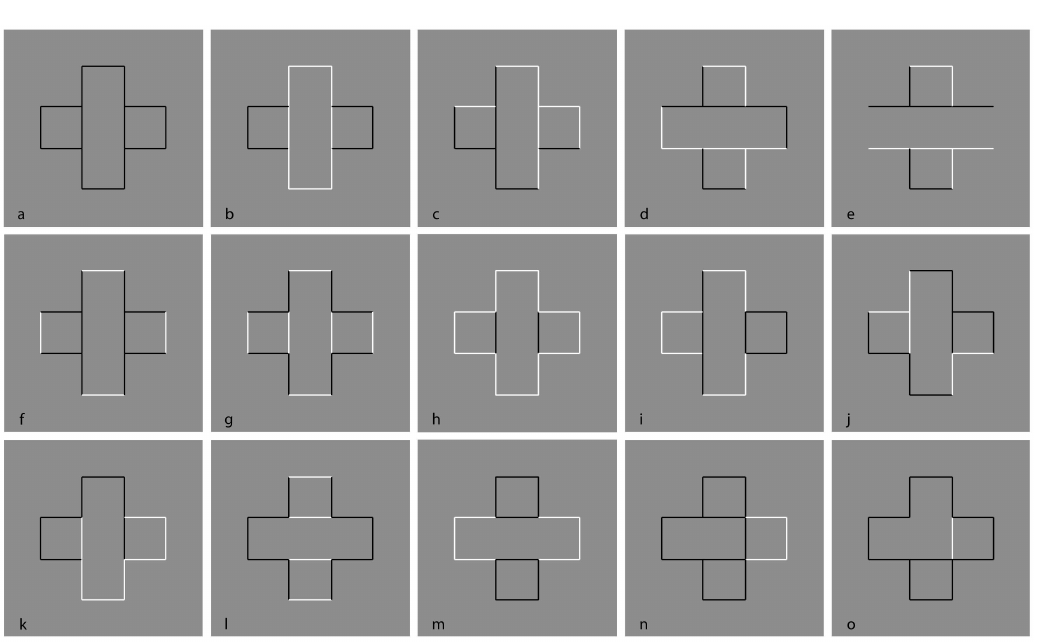
Figure 19. Conditions demonstrating the dominance of the contrast polarity over good continuation, T-junctions, regularity, simplicity, and likelihood.